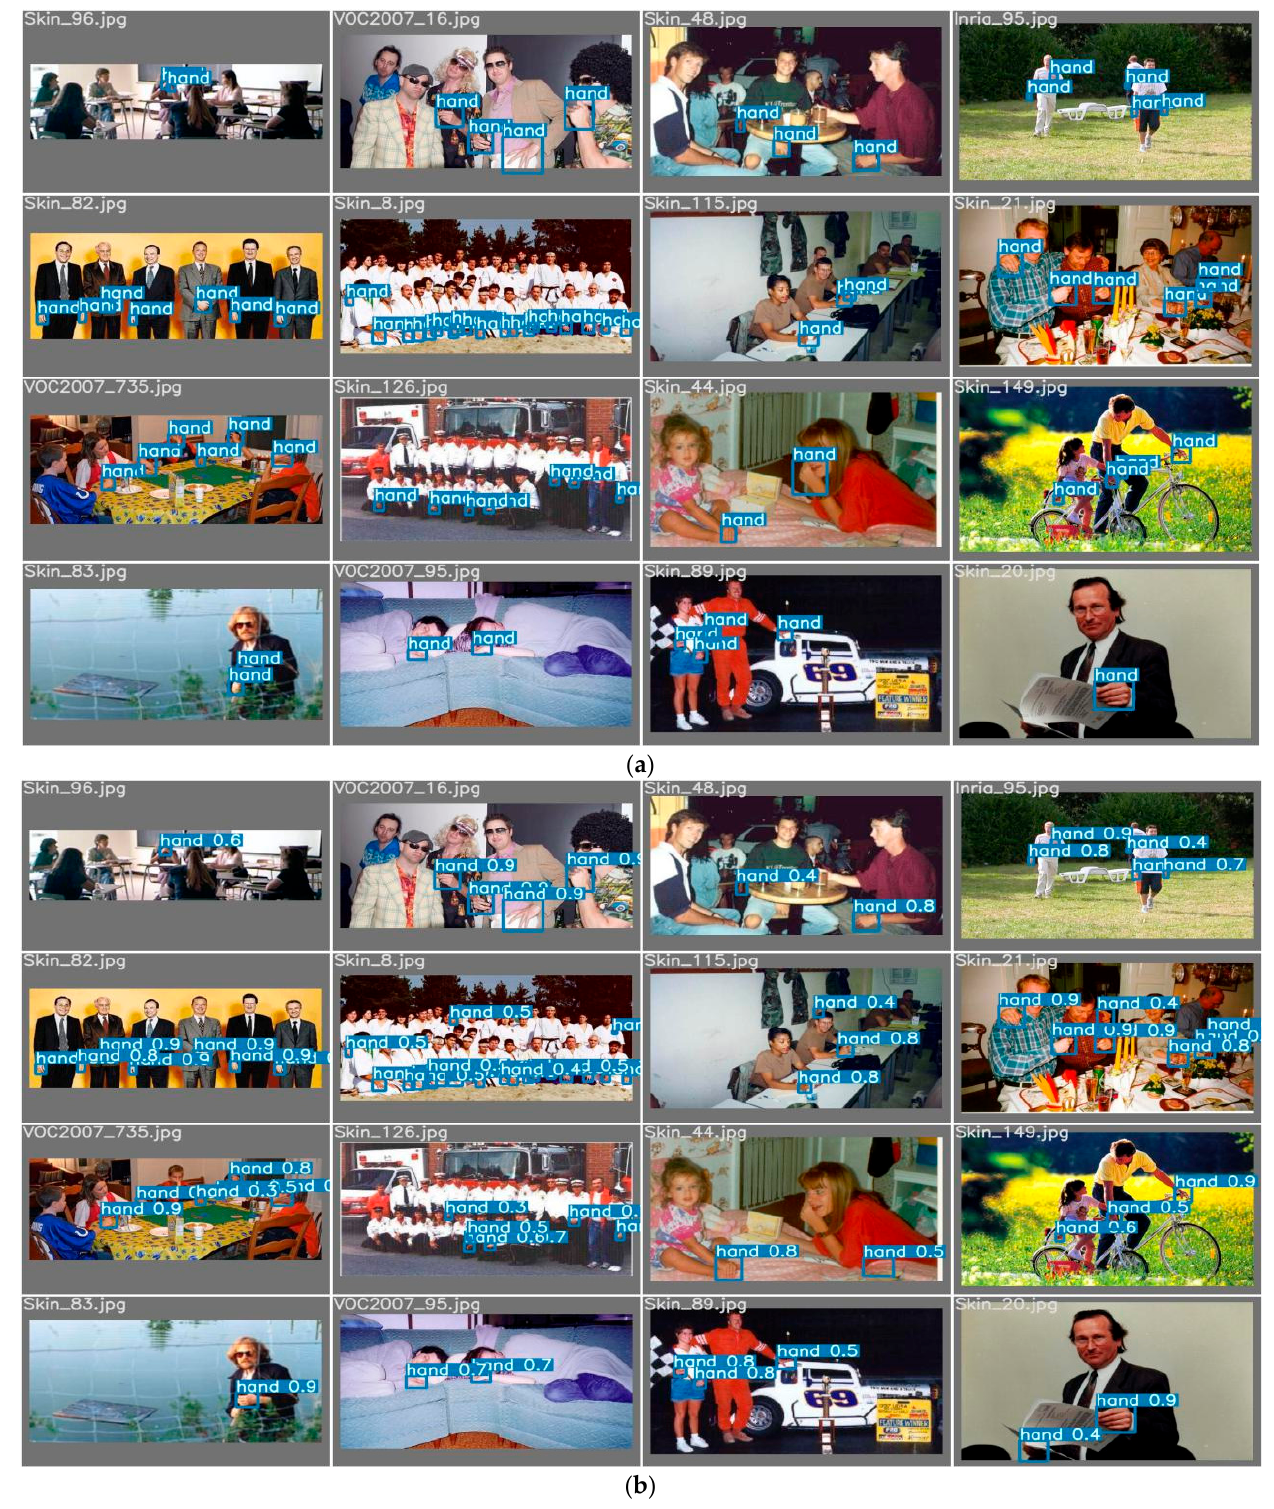
Figure 4. Test batch 0 labels and test batch 0 prediction. ( a ) Test batch 0 labels and ( b ) test batch 0 prediction. Source: The human faces in the figures are all from public datasets (Oxford Hand Dataset). Further, Yolov7 exhibits a precision value of 77.4%, recall of 66.3%, mAP of 74.2%,